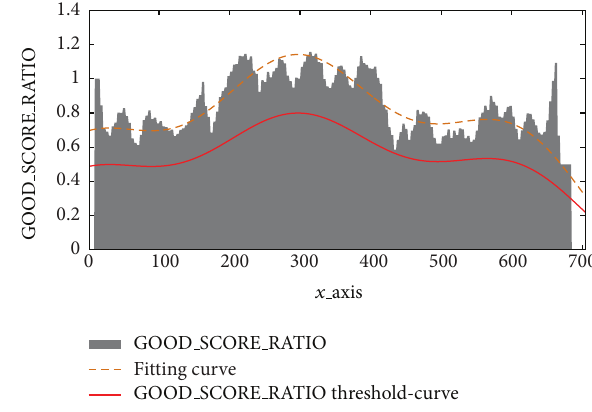
Figure 18: GOOD SCORE RATIO threshold-curve figure (see (9)).